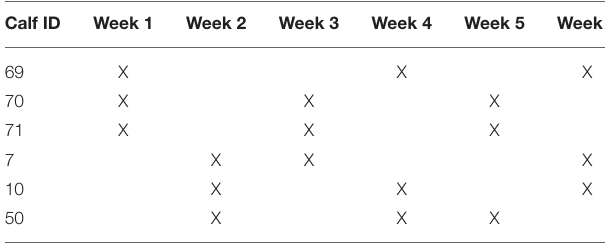
TABLE 1 | Timeline for sample